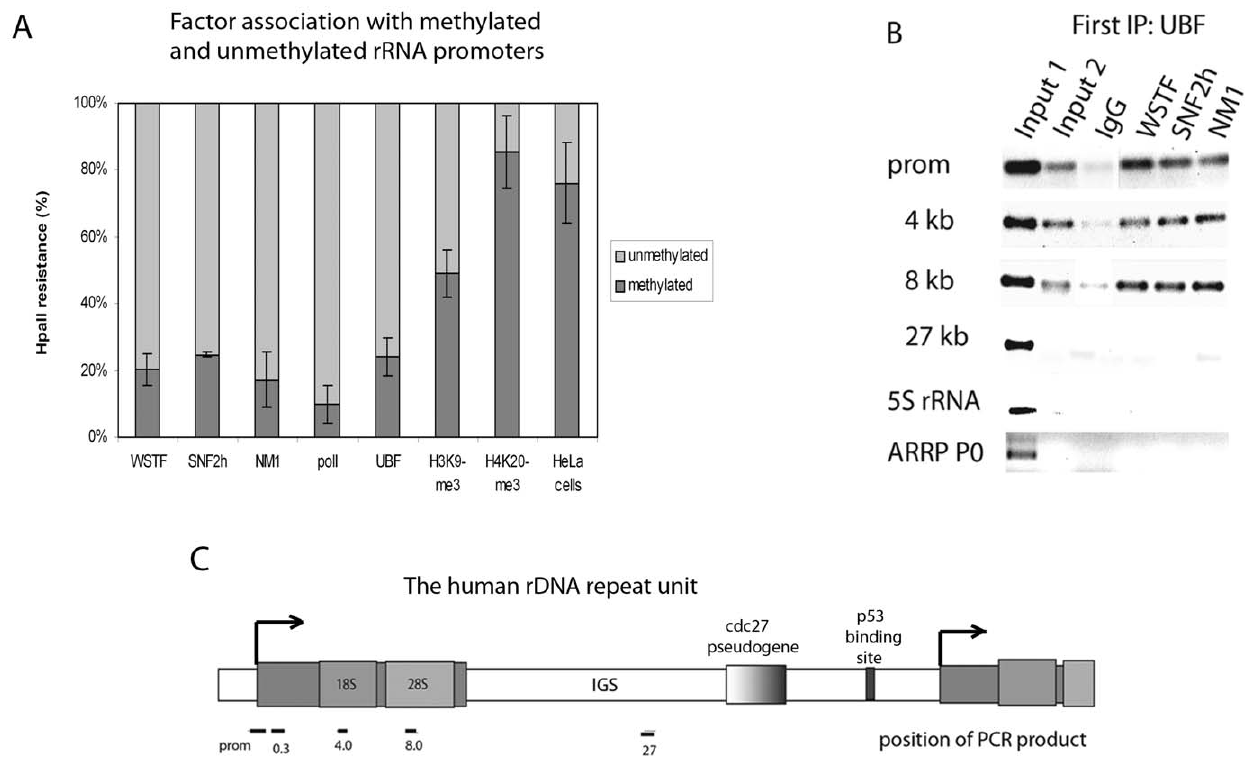
Figure 1. WSTF, SNF2h and NM1 associate with active rRNA genes. ( A ) HpaII and MspI digestion of DNA from ChIPs precipitated with antibodies against WSTF, SNF2h and NM1, RNA pol I, UBF, H3K9-me3 and H4K20-me3 as indicated. ‘‘HeLa cells’’ represents HpaII digestion of the input sample. The degree of methylation was correlated to the level of PCR product produced with a primer pair over the promoter. 100% represents 100% methylated promoter-DNA (not digested DNA), 0% represents no methylation of the promoter (the signal observed in digestions with MspI). Error bars represent standard deviations of five separate experiments. ( B ) Sequential ChIP using an UBF antibody in the first IP, and WSTF, SNF2h and NM1 and IgG antibodies as indicated in the second IP. Input 1 represents 5% of the chromatin used in the IP, input 2 represents 10% of the material released from the beads. The primer pairs used are shown in Fig. 1C, in addition to the 5S rRNA, and at the ARRP P0 gene as indicated. ( C ) Schematic image of the human rDNA repeat unit, with the position of the PCR product formed from the primer pairs for the ribosomal gene